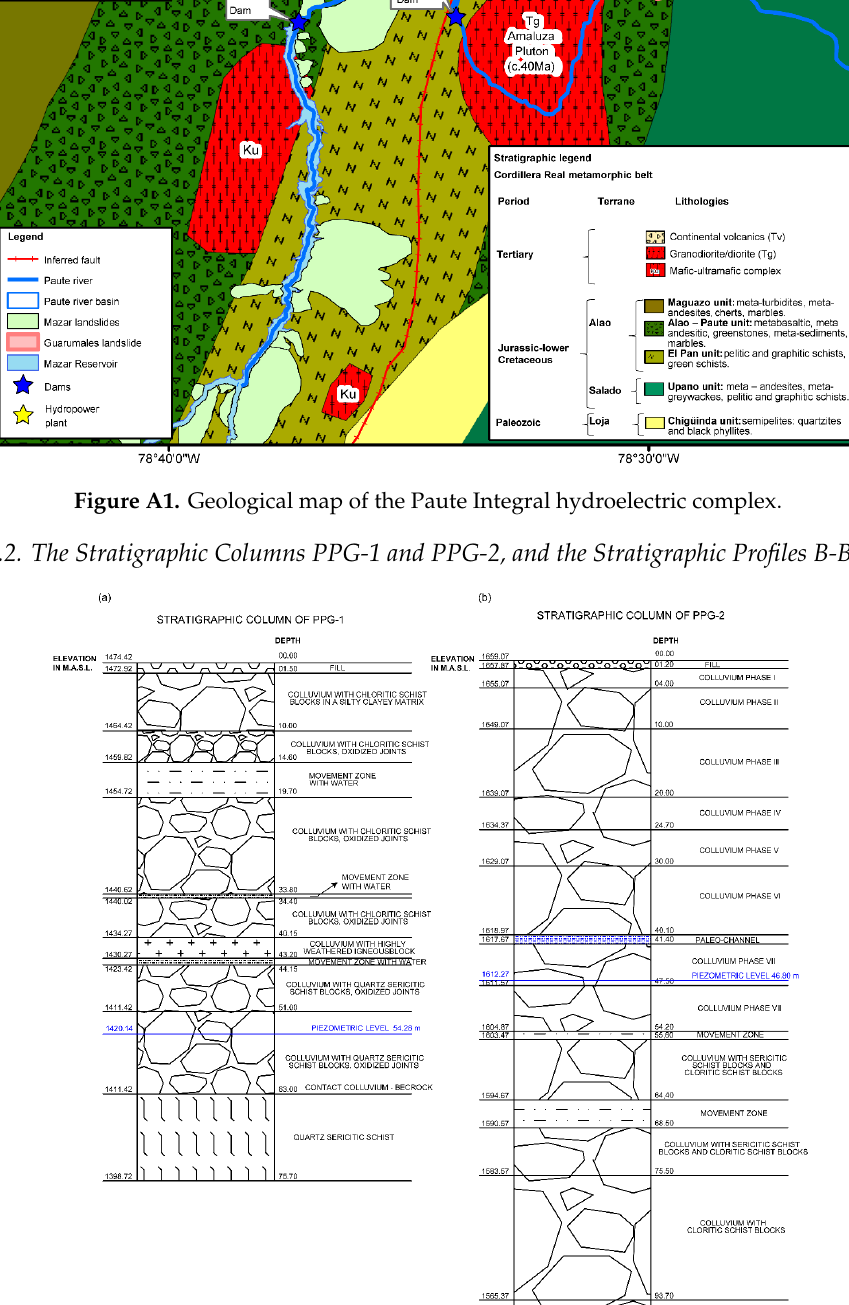
Figure A2. Stratigraphic columns for boreholes PPG-1 ( a ) and PPG-2 ( b ).